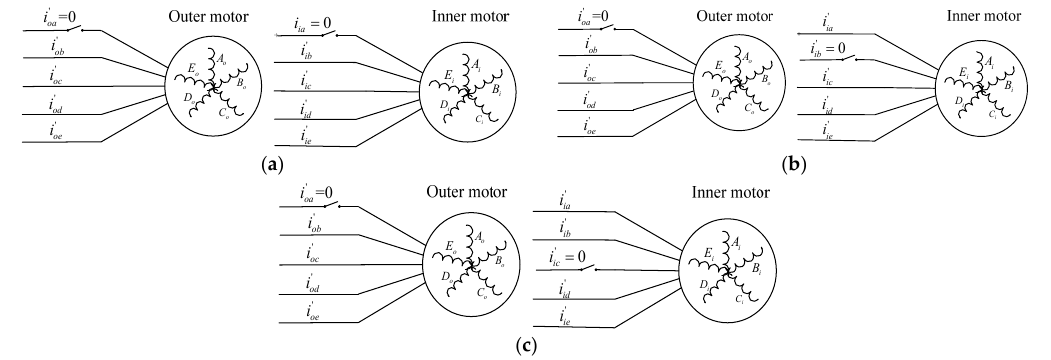
Figure 17. Single ‐ phase open ‐ circuit fault types in both inner motor and outer motor. ( a ) Same phase Figure 17. Single-phase open-circuit fault types in both inner motor and outer motor. ( a ) Same phase in inner motor and out motor are open open ‐ circuit; ( b ) “adjacent phase” in inner motor and out motor in inner motor and out motor are open open-circuit; ( b ) “adjacent phase” in inner motor and out motor are open open ‐ circuit; ( c ) “non ‐ adjacent phase” in inner motor and out motor are open open ‐ circuit. are open open-circuit; ( c ) “non-adjacent phase” in inner motor and out motor are open